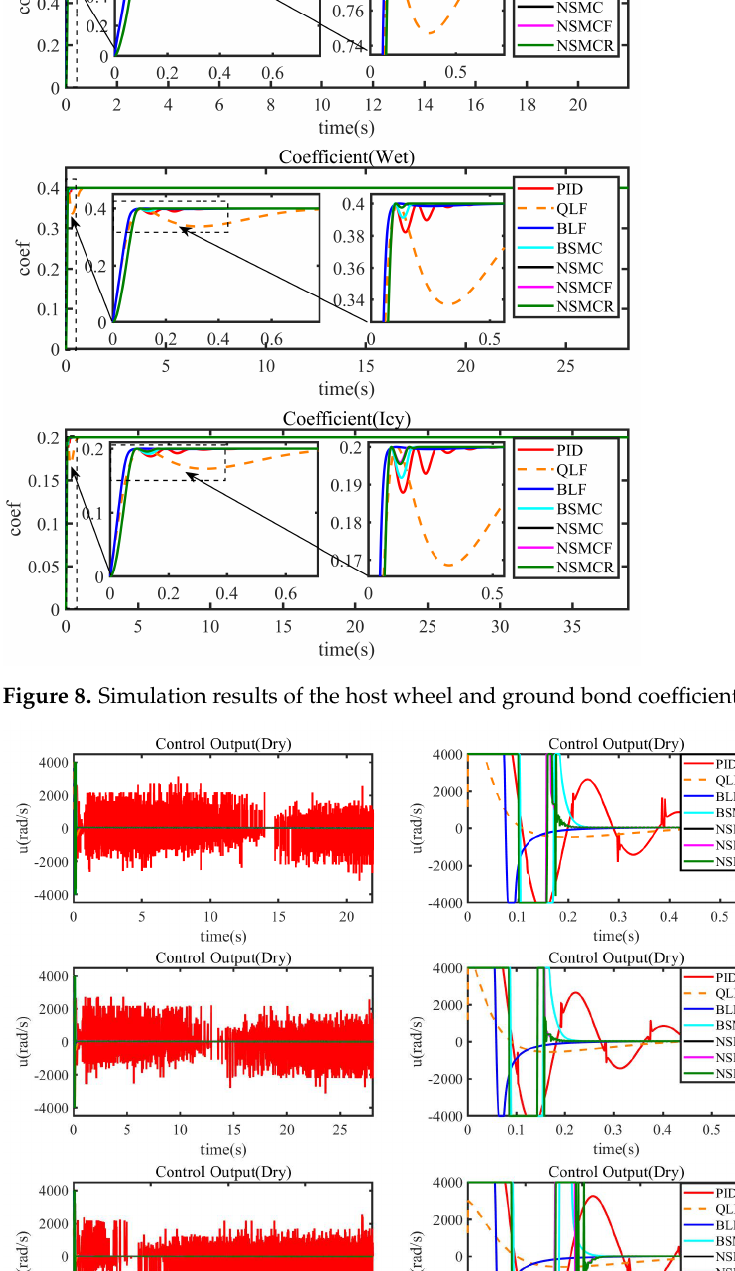
Figure 7. Simulation results of main wheel slip rate tracking.